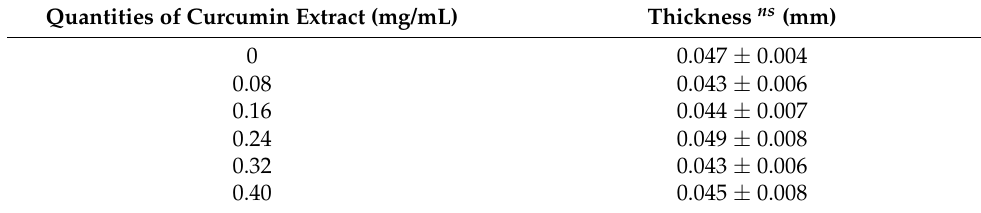
Table 1. Thickness of chitosan film incorporated with curcumin extract. Quantities of Curcumin Extract (mg/mL)